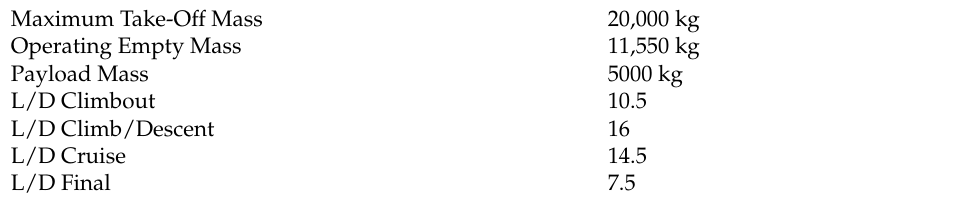
Table 2. Aircraft